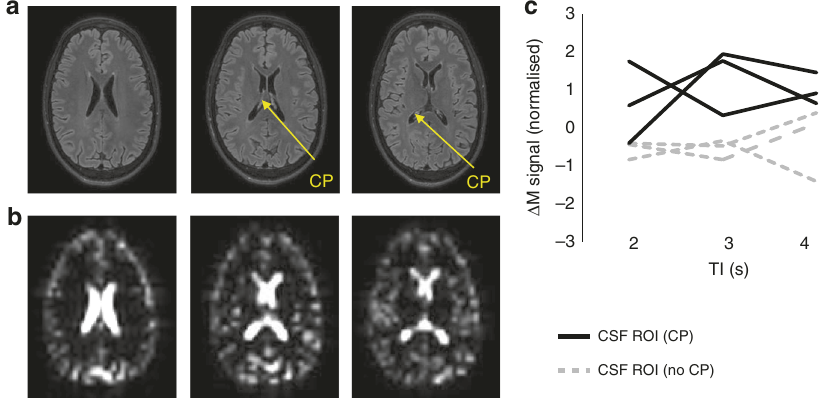
Fig. 4 Non-invasive MRI of BCSFB function: proof of application to the human brain at 3T. a High resolution FLAIR structural images showing the location of CP tissue within the lateral ventricles. b Corresponding axial control ASL images at TE = 400 ms. c The mean ASL signal (normalised to the average ASL signal in CP containing ROIs) as a function of TI for CSF regions with (black line) and without (grey line) CP tissue. Each line represents an individual subject ( n = 3 biological replicates on three healthy volunteers over three separate